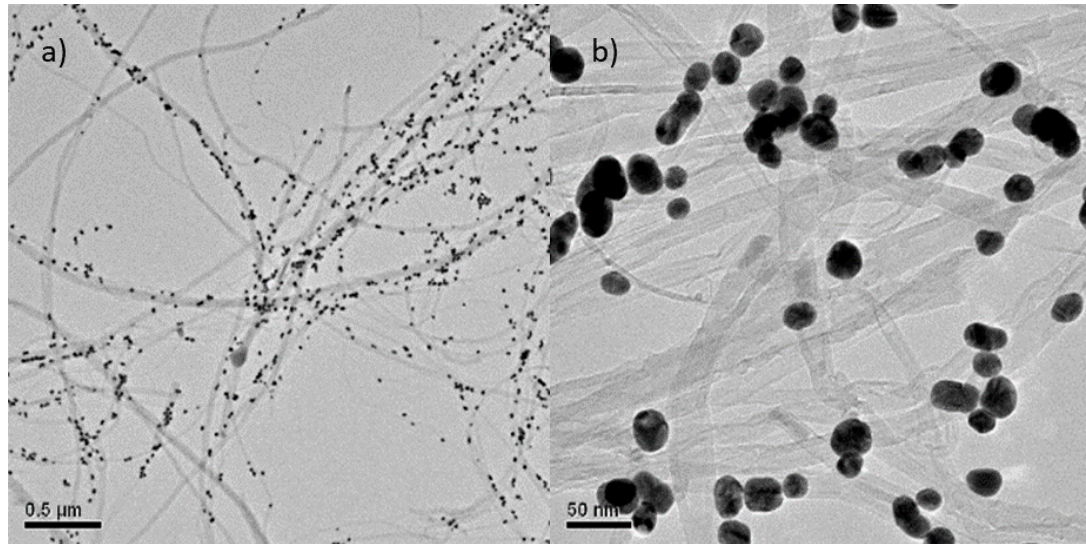
/ AuNP composite in ( a ) 0.5 µ m and ( b ) 50 nm Figure 1. TEM images of multi-walled CNT/AuNP composite in ( a ) 0.5 µm and ( b ) 50 nm scale. Figure 1. TEM images of multi-walled CNT